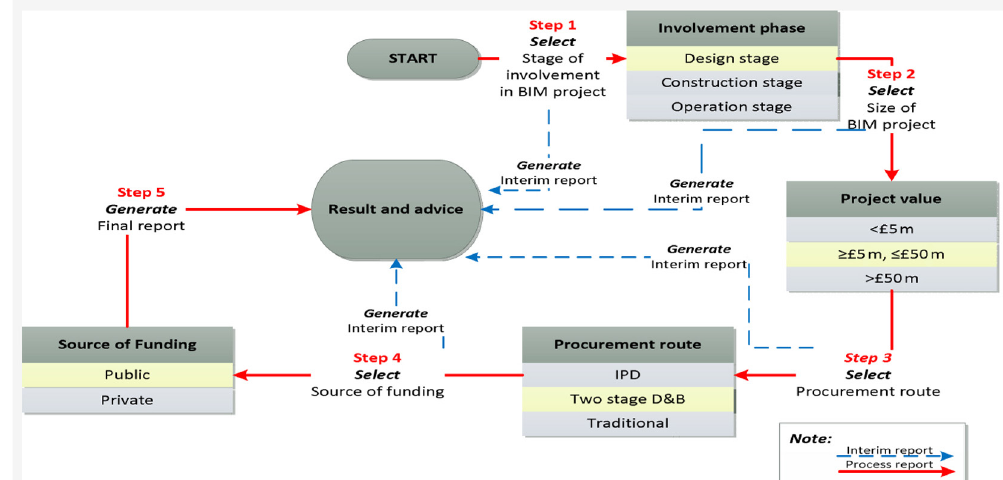
Fig. 2. The workflow diagram of the framework